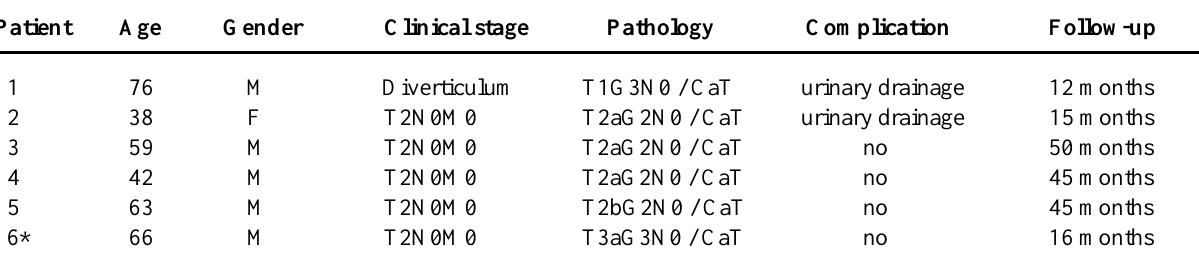
Table 1 – Patients’